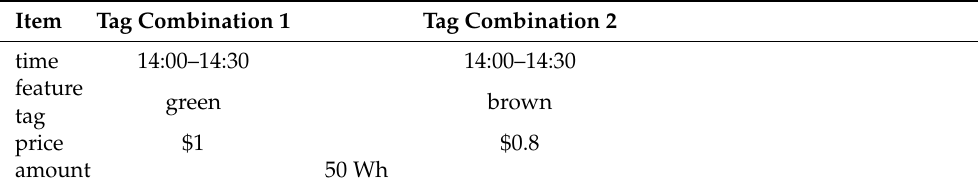
Table 4. Example of bid expressing needs for renewable energy